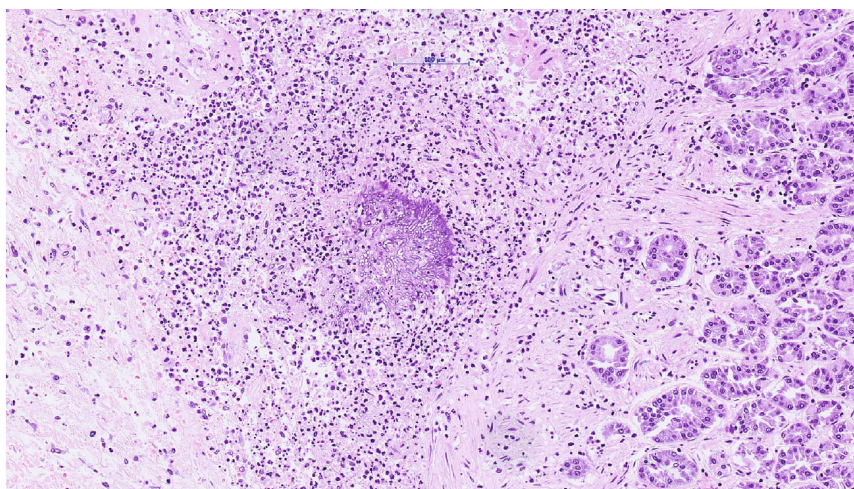
Figure 3: Hematoxylin-eosin staining of the stomach with submucosal aspergillus (20x magni fi cation).